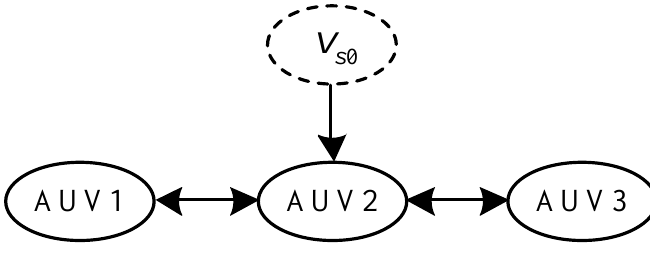
Figure 4. Communication topology of three AUVs.